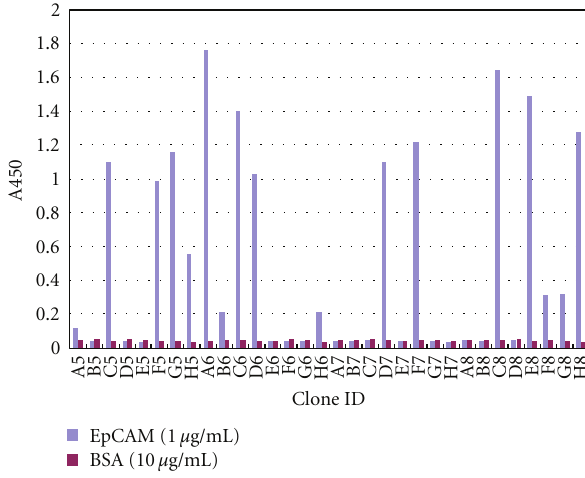
Figure 1: The screening of phage clones displaying anti-EpCAM scFv by monoclonal phage ELISA. The binding of phages displaying anti-EpCAM scFv to immobilized EpCAM (white bar) or BSA (gray bar) was detected by an HRP-labeled anti-M13